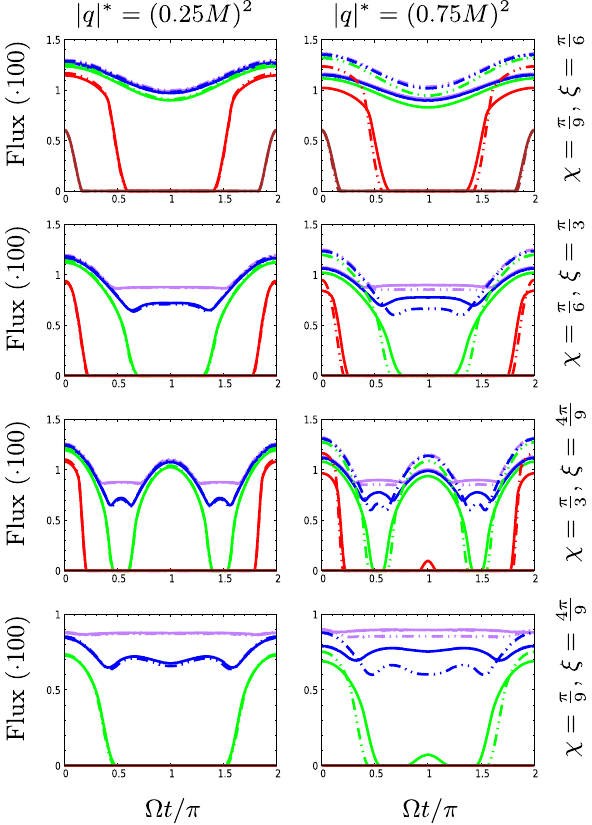
Fig. 30 Pulseprofileforantipodalcaps.Exponentialdecay, R / r h = 3. Purple, blue, green, green, red and brown lines correspond to (cid:11) = 0 . 00, 0 . 30, 0 . 60, 0 . 90 and 0 . 99 respectively. The solid lines correspond to q ∗ > 0 while the dashed lines correspond to q ∗ < 0